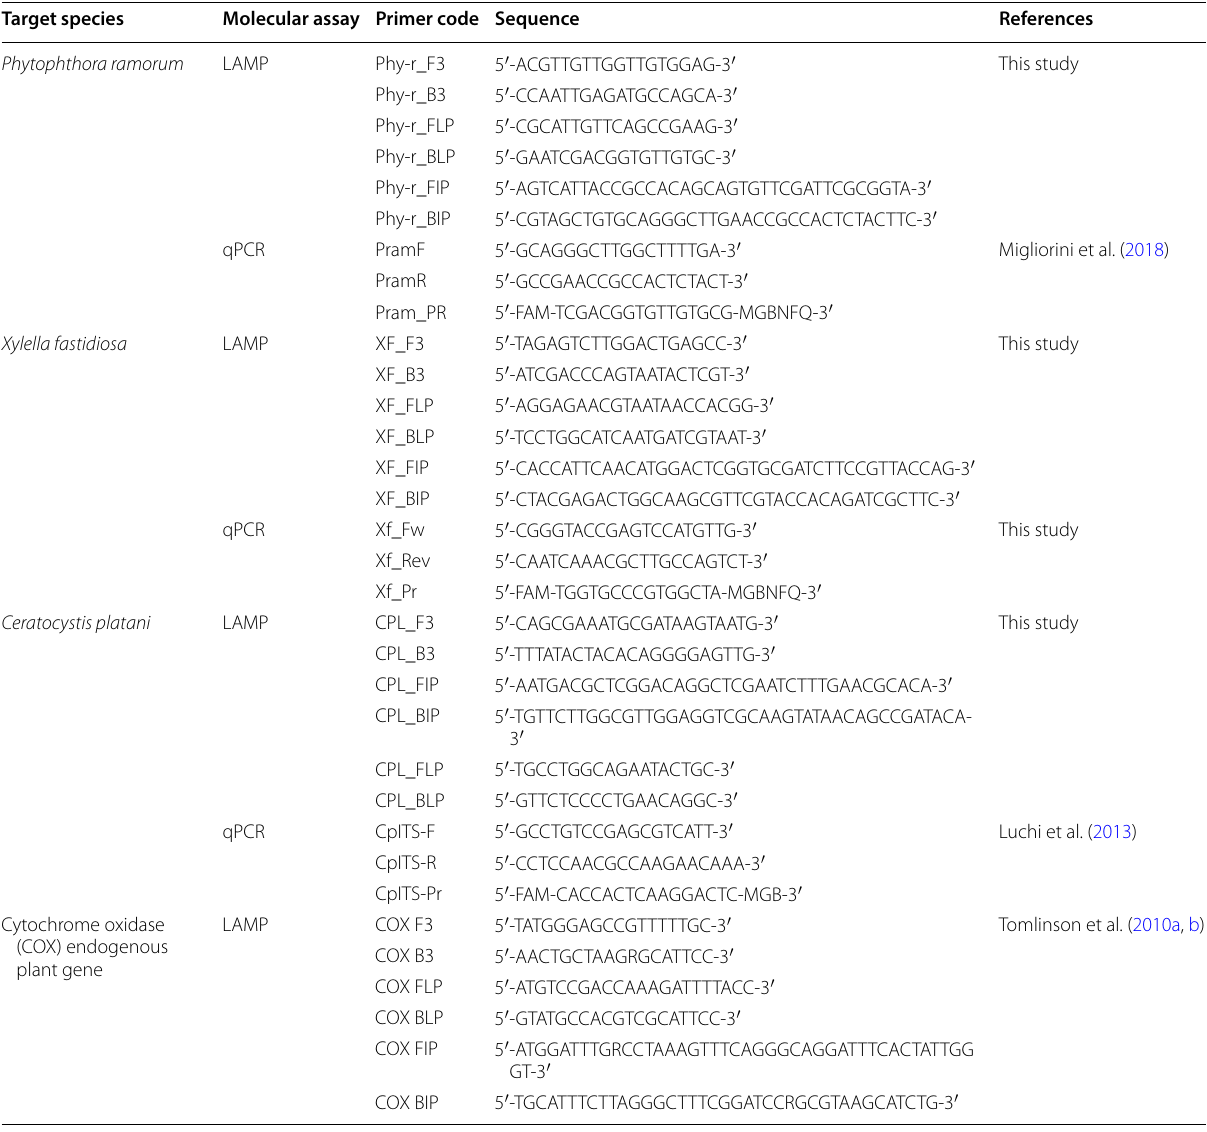
Table 2 List of primer set used in this study Target species Molecular assay Primer code